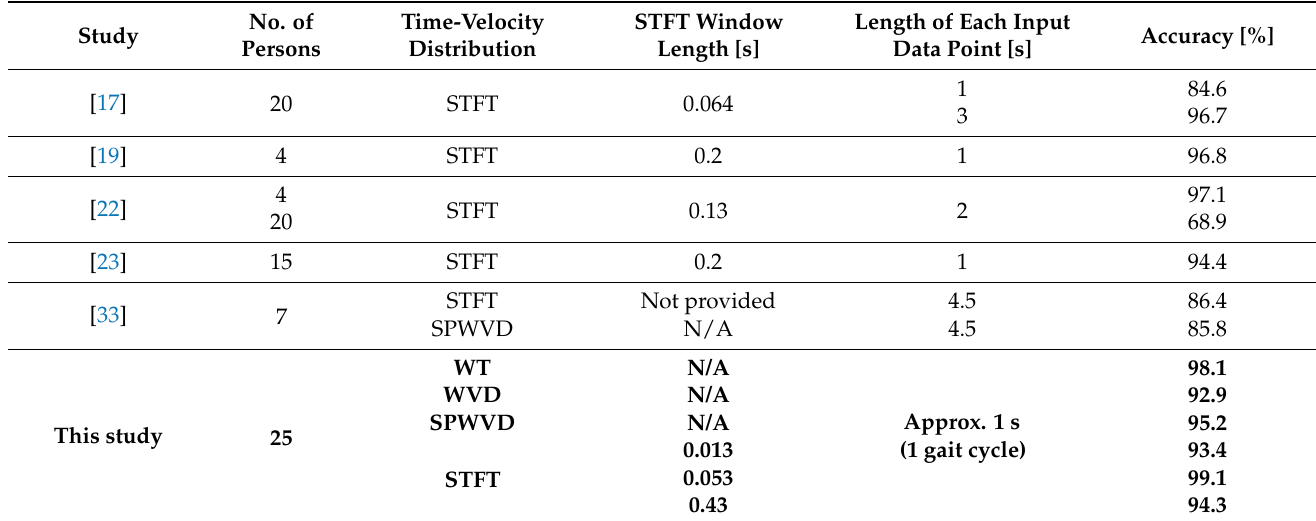
Table 4. Comparison of Different Studies on Doppler-Radar-Based Personal Gait